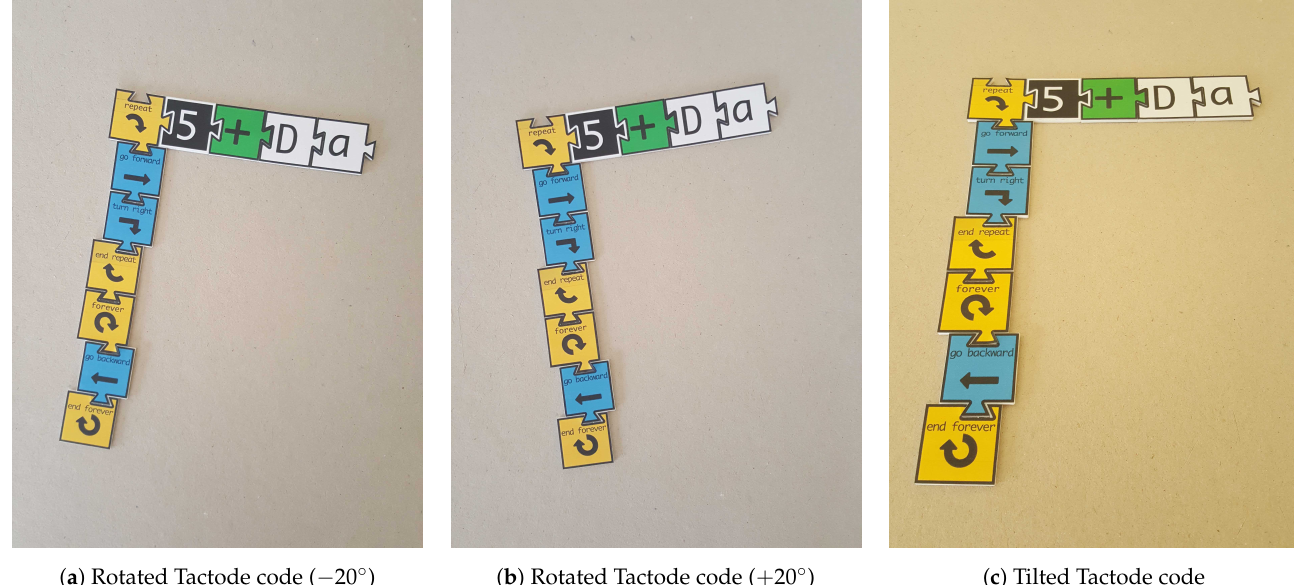
Figure A3. Three Tactode codes demonstrating the rotation ( a , b ) and tilt ( c ) present in the